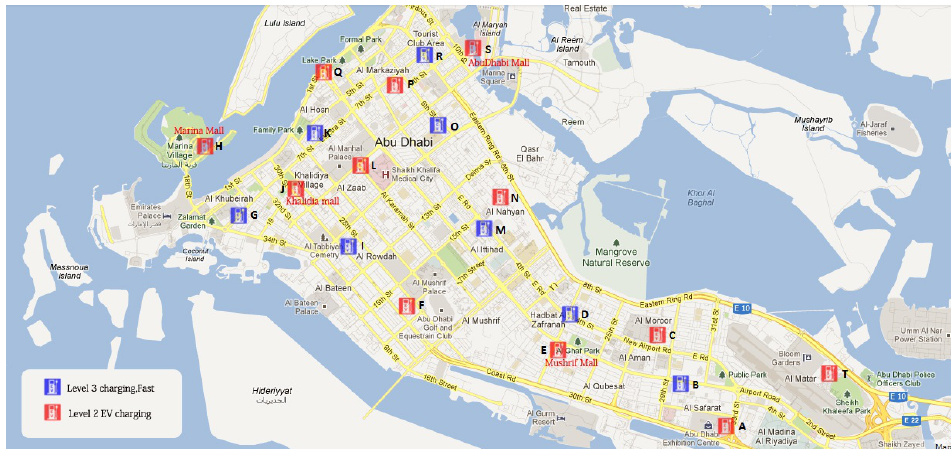
Figure 8. Full Charging System Design Map.